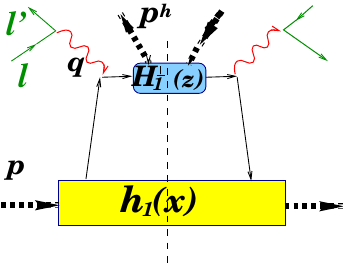
Fig. 2 The diagram describing the contribution to the SIDIS cross section of PDF h 1 ( x ) convoluted with FF H ⊥